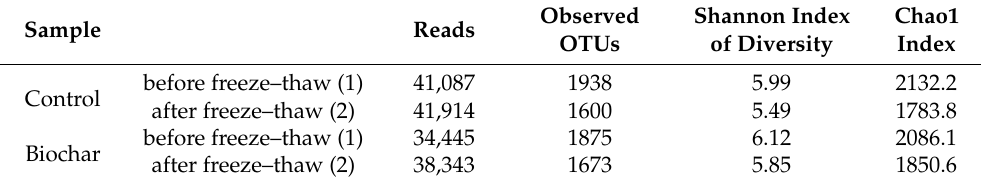
Table 1. Alpha diversity (within sample diversity) values for phytostabilized non-amended (control) and biochar-amended soil samples calculated based on the amplicon analysis. Phytostabilization was carried out under the following conditions: (1) greenhouse temperatures (before freeze-thaw)